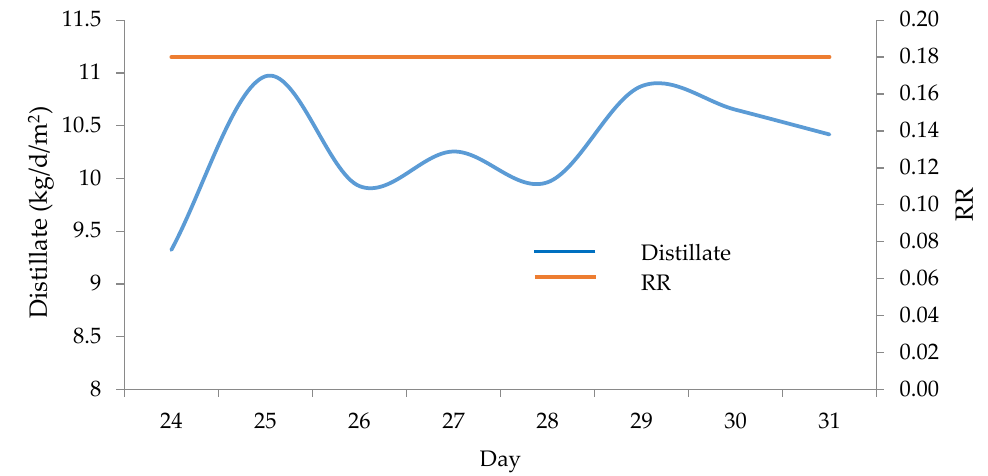
Figure 9. Variations of total distillate production rate and recovery ratio (RR). Performance Ratio (PR)